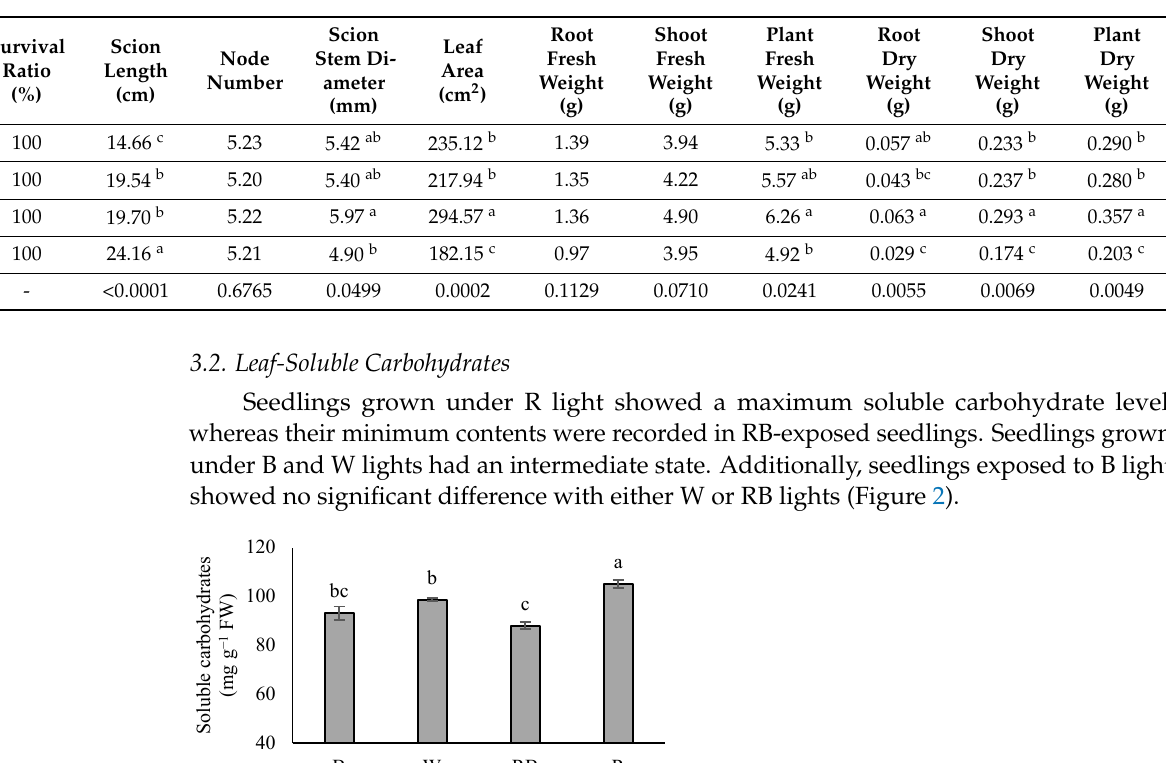
Table 1. The morphological and growth parameters of grafted tomato seedlings exposed to different light regimes for 20 days under a light intensity of 75 ± 5 µmol m − 2 s − 1 PPFD. The light quality treatments included white light (W) as control, blue (B), red (R), and a combination of red (68%) and blue (RB) lights. The spectral composition of the RB light treatment can be found in Figure 1. Values with the same letters are not significantly different at p ≤ 0.05, according to Duncan’s multiple range tests.